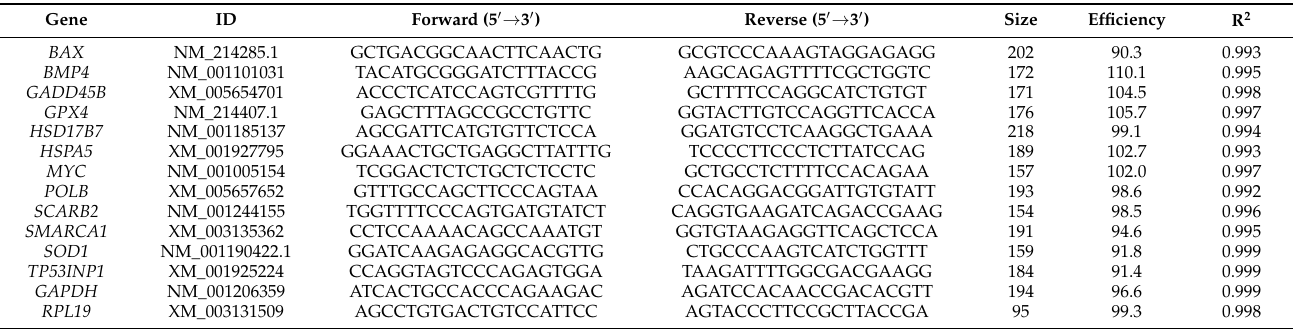
Table 1. Sequences of the primers used for validation of the microarray results by